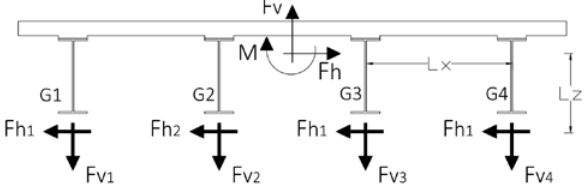
Figure 11. Free body diagram showing applied loads and reaction forces for the simplified method.